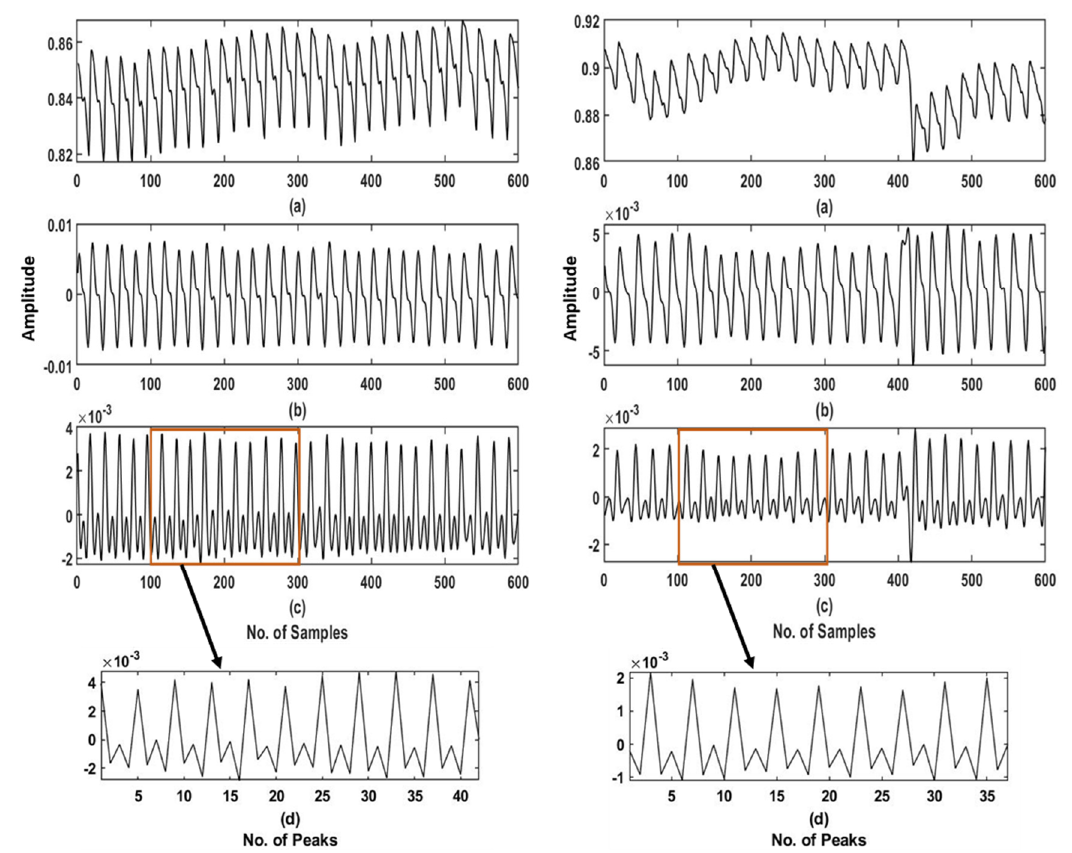
Figure 8. Two representative PPG signals—(left): relatively prominent PPG signal and (right): a signal with high baseline issues and noises processed through different steps. ( a ) Raw PPG Signal; ( b ) PPG signal preprocessed with ALS and Gaussian filter; ( c ) first derivative of preprocessed signal, and ( d ) extracted features of first derivative signal.